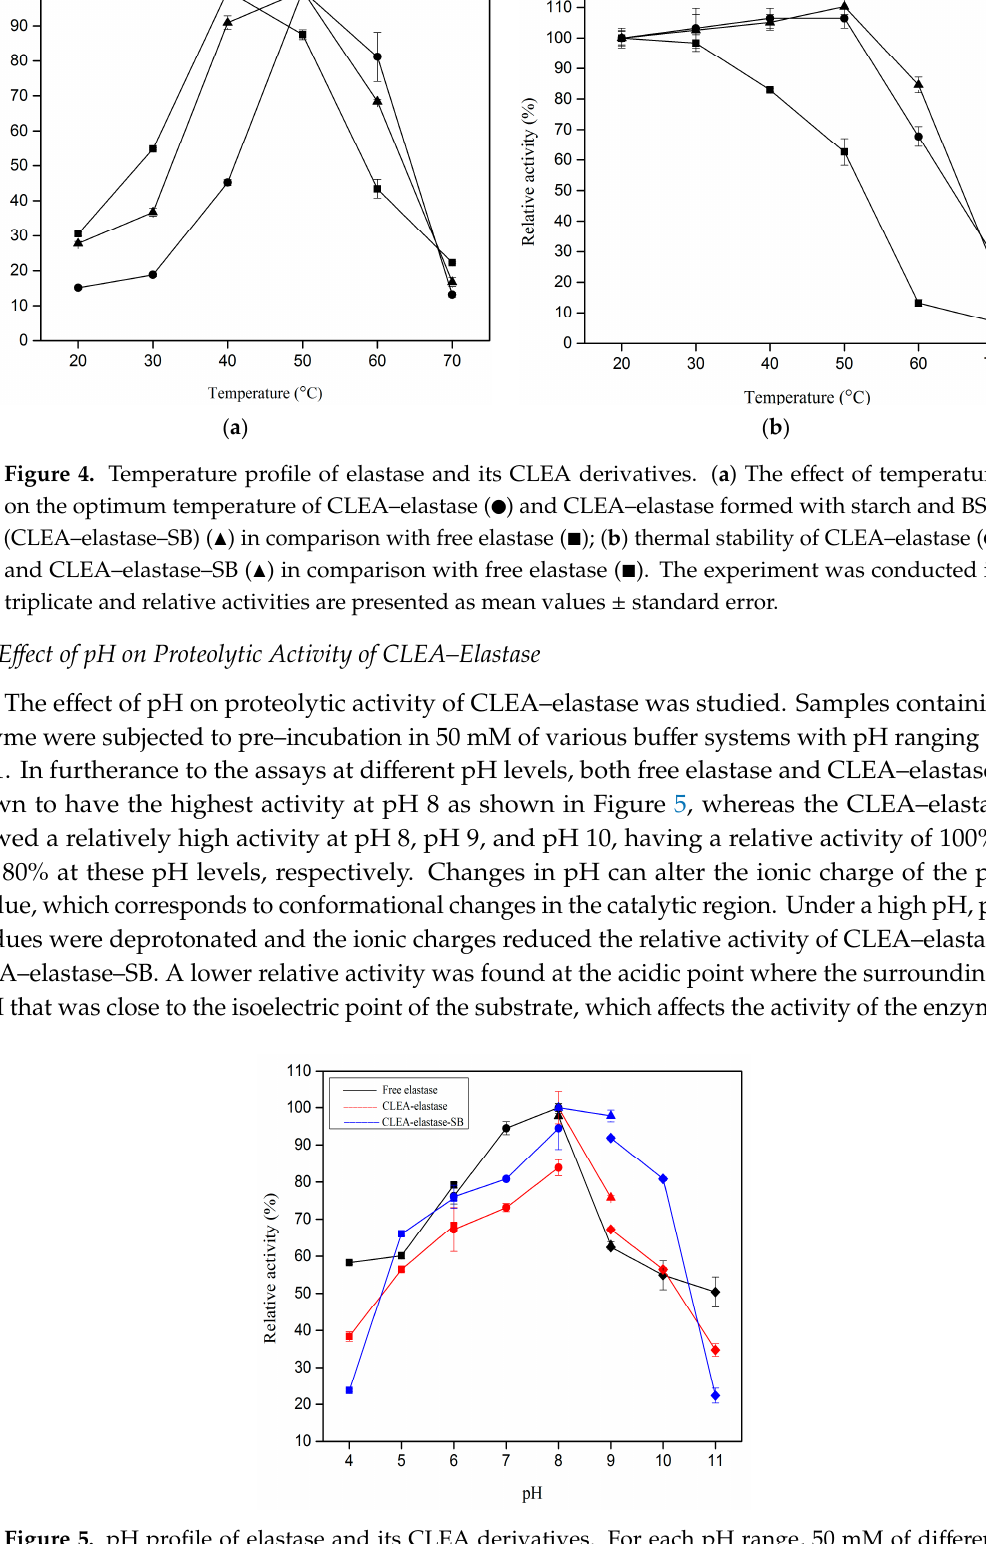
Figure 5. pH profile of elastase and its CLEA derivatives. For each pH range, 50 mM of different buffer systems was used, namely, sodium acetate ( (cid:4) ), potassium phosphate ( (cid:8) ), Tris–Cl, ( (cid:78) ) and glycine–OH ( (cid:95) ). The experiment was conducted in triplicate and relative activities are presented as mean values ± standard error.